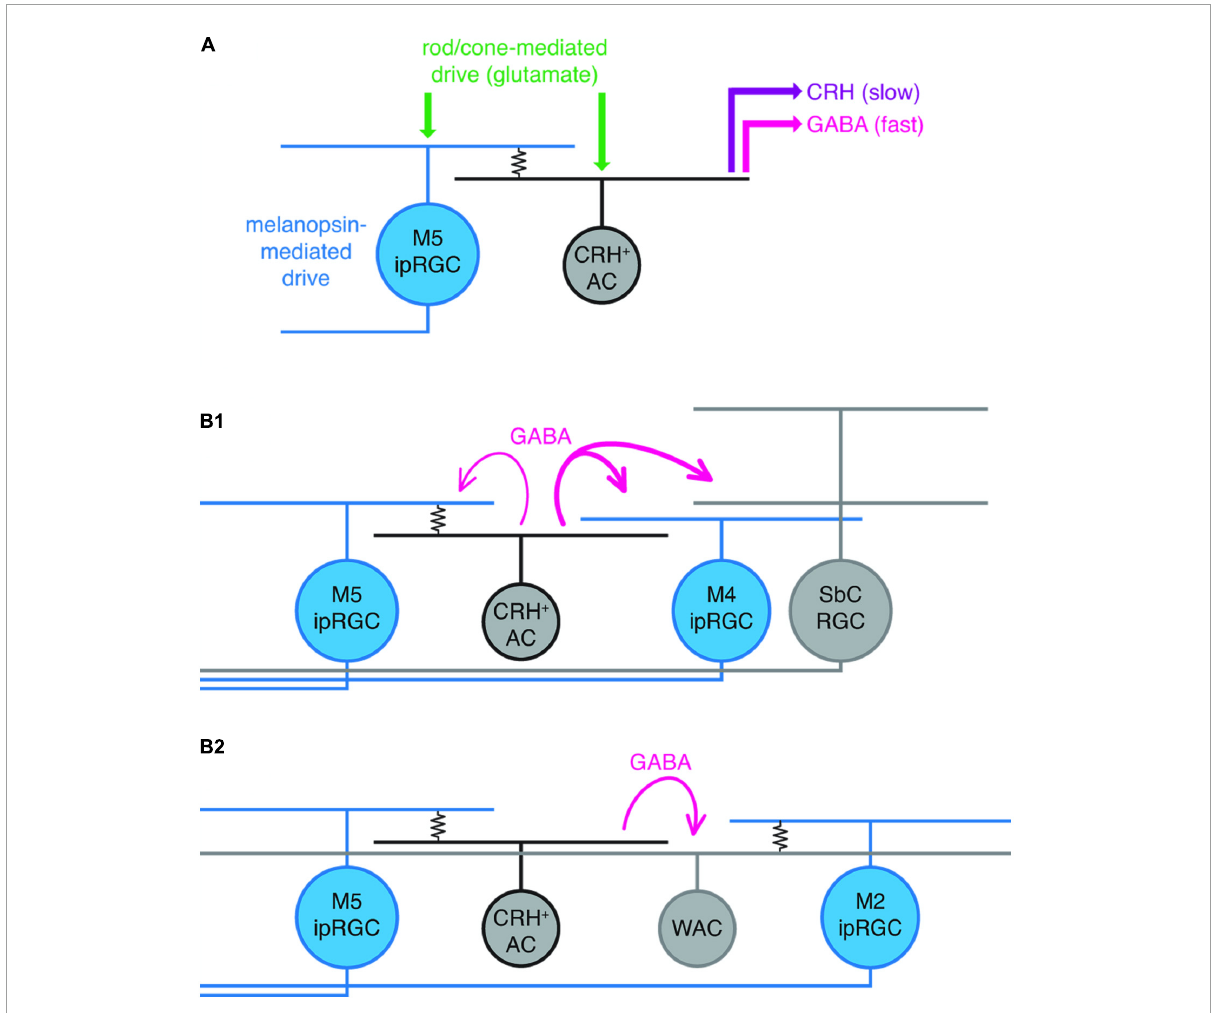
FIGURE2 Summary of hypothesized ipRGC intraretinal connectivity of M5 ipRGCs in the mouse retina. (A) M5 to corticotropin-releasing hormone-expressing amacrine cell (CRH + AC) electrical coupling (resistor symbol), in addition to glutamate-mediated excitatory input to both M5 ipRGCs and CRH ACs (originating from rods and cones), drives GABA and CRH release from CRH ACs. (B1) Strong (thick magenta lines) feedforward GABAergic inhibition of M4 ipRGCs and a suppressed-by-contrast (SbC) RGC from an M5 coupled CRH + AC; modest (thin magenta) GABAergic feedback inhibition to an electrically coupled M5 ipRGC. (B2) M5 ipRGC electrically coupled to a CRH + AC drives feedforward inhibition of a wide-field amacrine cell (WAC) that is electrically coupled to an M2 ipRGC. Reproduced with permission from Pottackal et al.